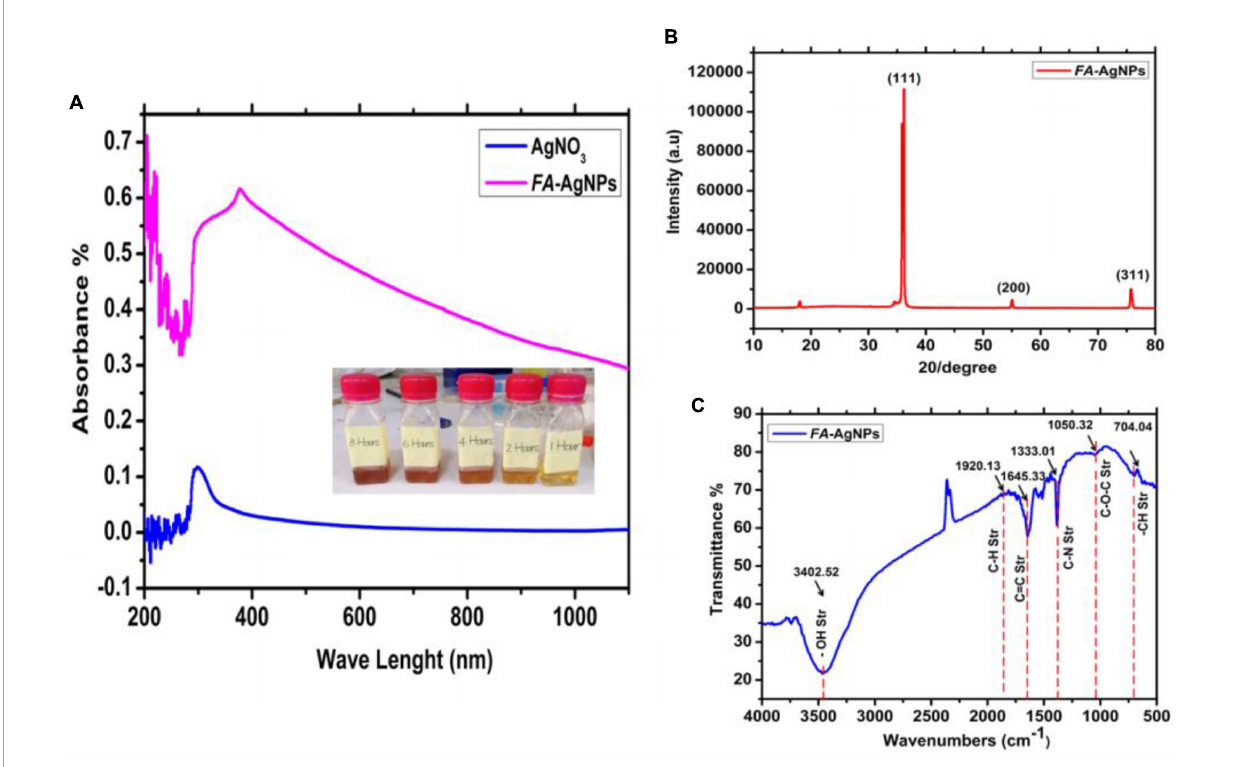
FIGURE3 (A) UV-Vis spectroscopy and color change of silver nanoparticles synthesized by green synthesis method at room temperature. (B) XRD pattern of bare AgNPs; (C)